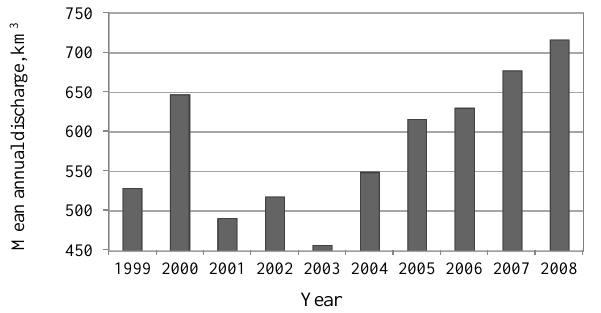
Fig. 3. Mean annual Lena River discharge (Kusur observation sta- tion) documented during the period of Buor-Khaya Bay observa- tions.